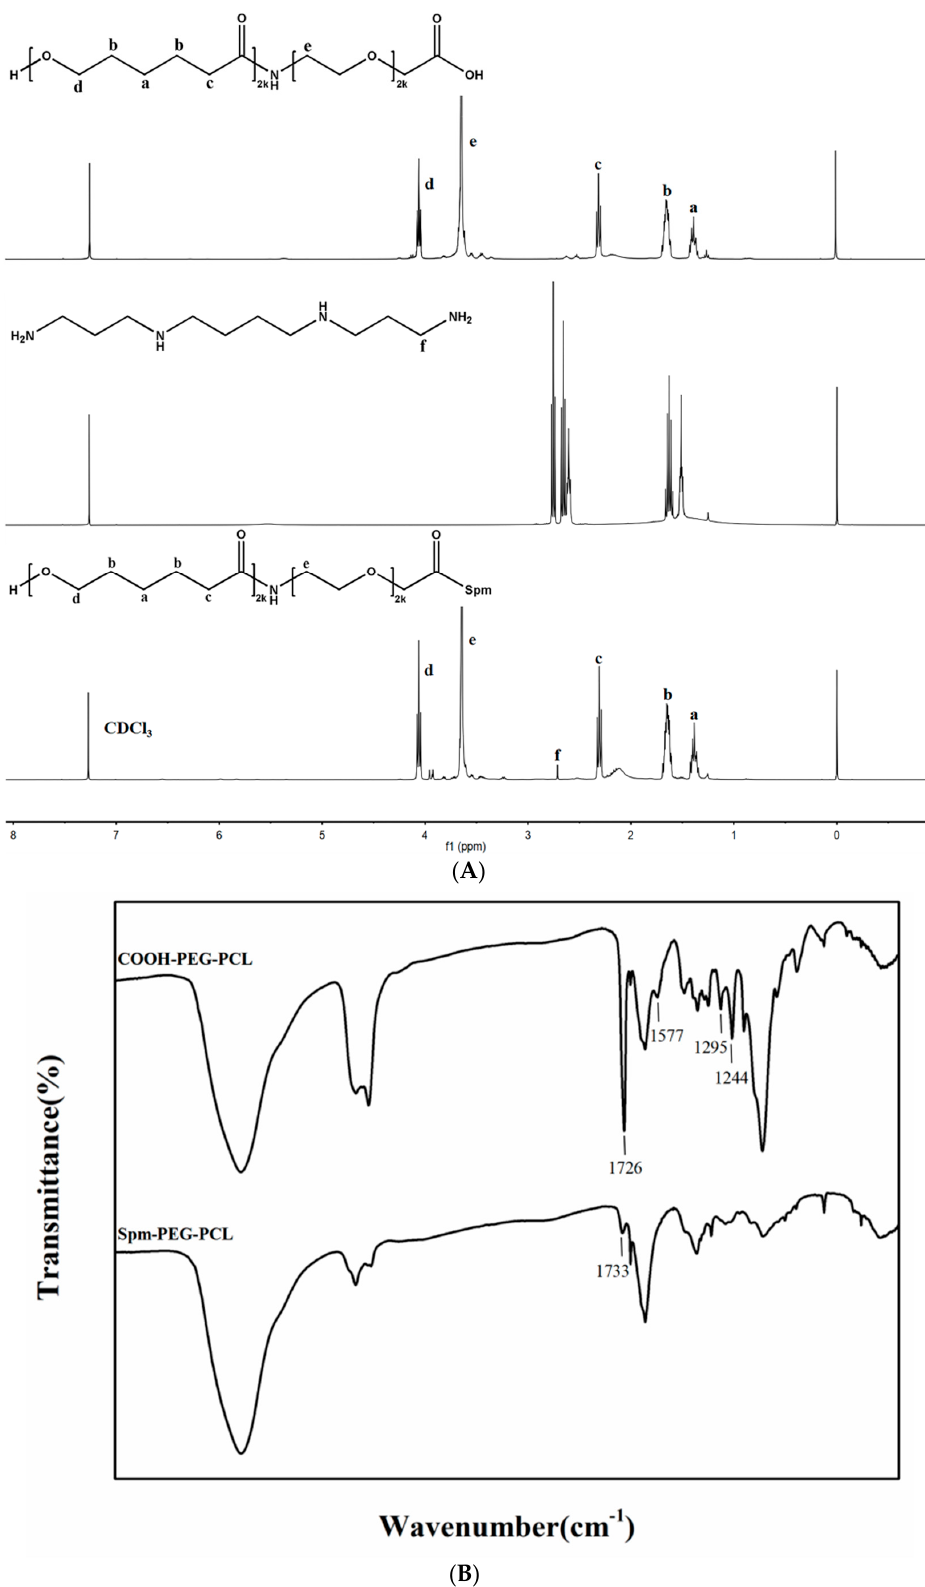
Figure 1. Synthesis route to Spm-PEG-PCL copolymer.